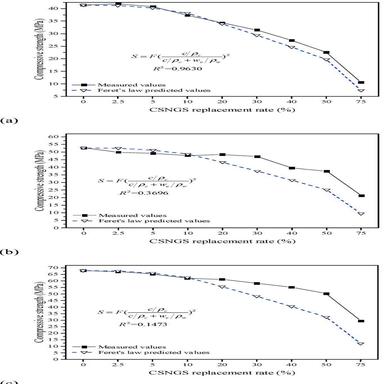
Comparison of the measured compressive strength and the predicted compressive strength by the Feret's law, (a) 7 d (b) 28 d (c) 90 d.